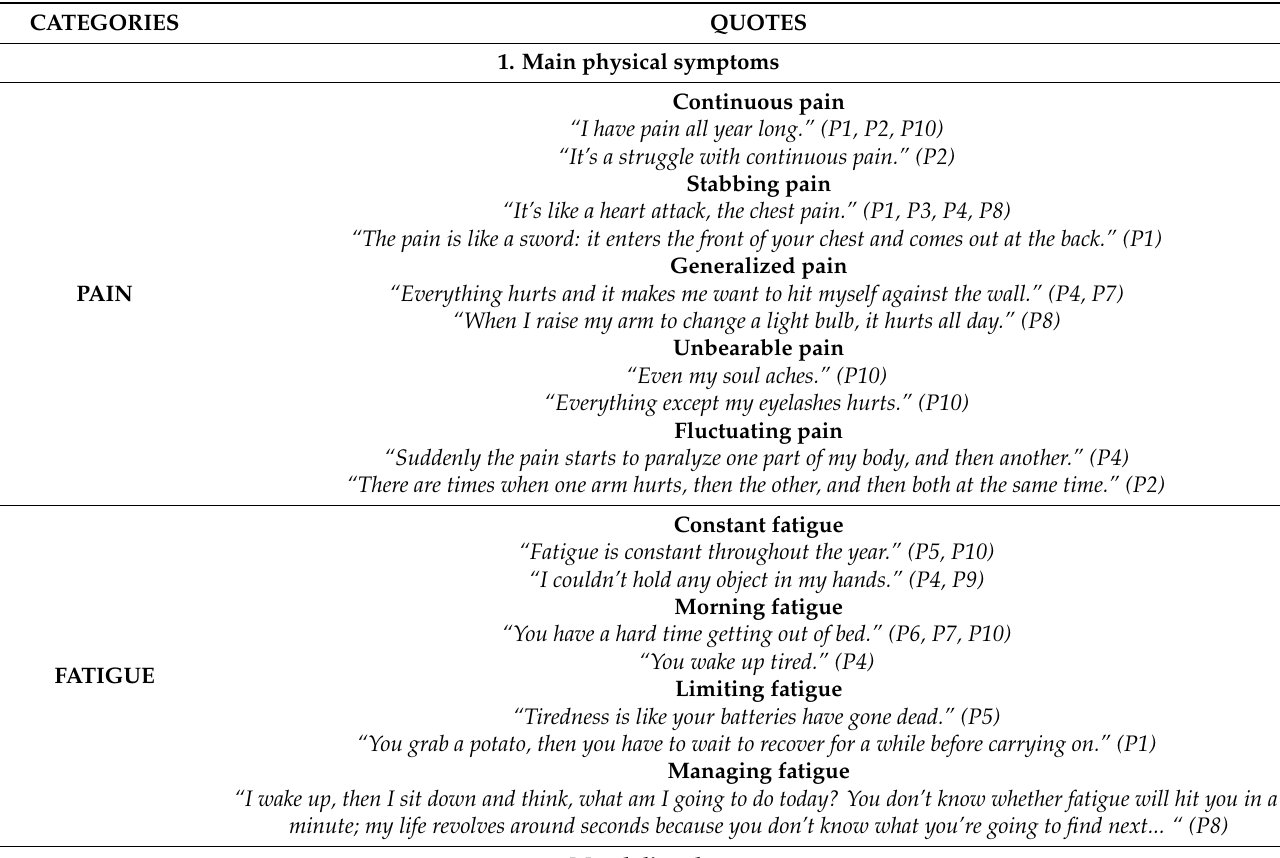
Table 1. Categories and quotes on the symptomatology of men with